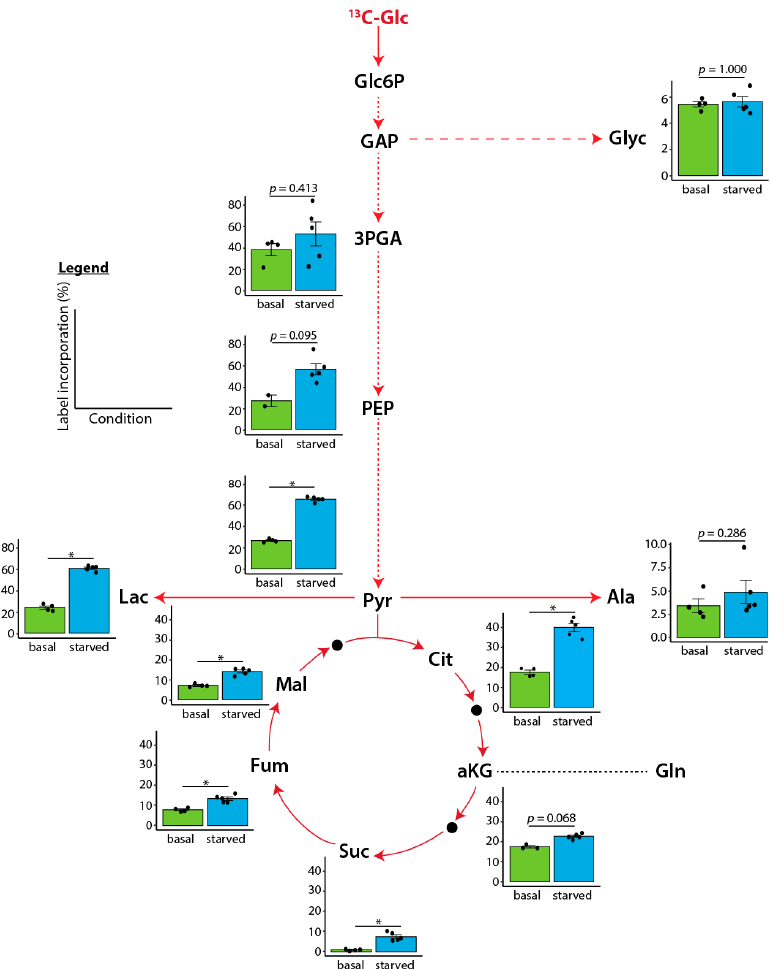
Figure 2. Incorporation of central carbon metabolites after labeling with 13 C-glucose (Glc) for 3 h. Bar charts show the individual values and the means ± SEM of the label incorporation (in %). Significance was calculated using the Mann–Whitney U test. Significance levels are * p < 0.05 or as indicated. HUVECs from n = 4 different donors for basal conditions (except of n = 2 for PEP) and n = 5 for serum starvation. Abbreviations (from top to bottom): Glc: Glucose. Glc6P: glucose-6- phosphate. GAP: glyceraldehyd-3-phosphate. Glyc: glycerol. 3PGA: glyceric-acid-3-phosphate. PEP: phosphoenolpyruvic acid. Pyr: pyruvic acid. Lac: lactic acid. Ala: alanine. Cit: citric acid. Mal: malic acid. Fum: fumaric acid. aKG: alpha-ketoglutaric acid. Gln: glutamine. Suc: succinic acid.